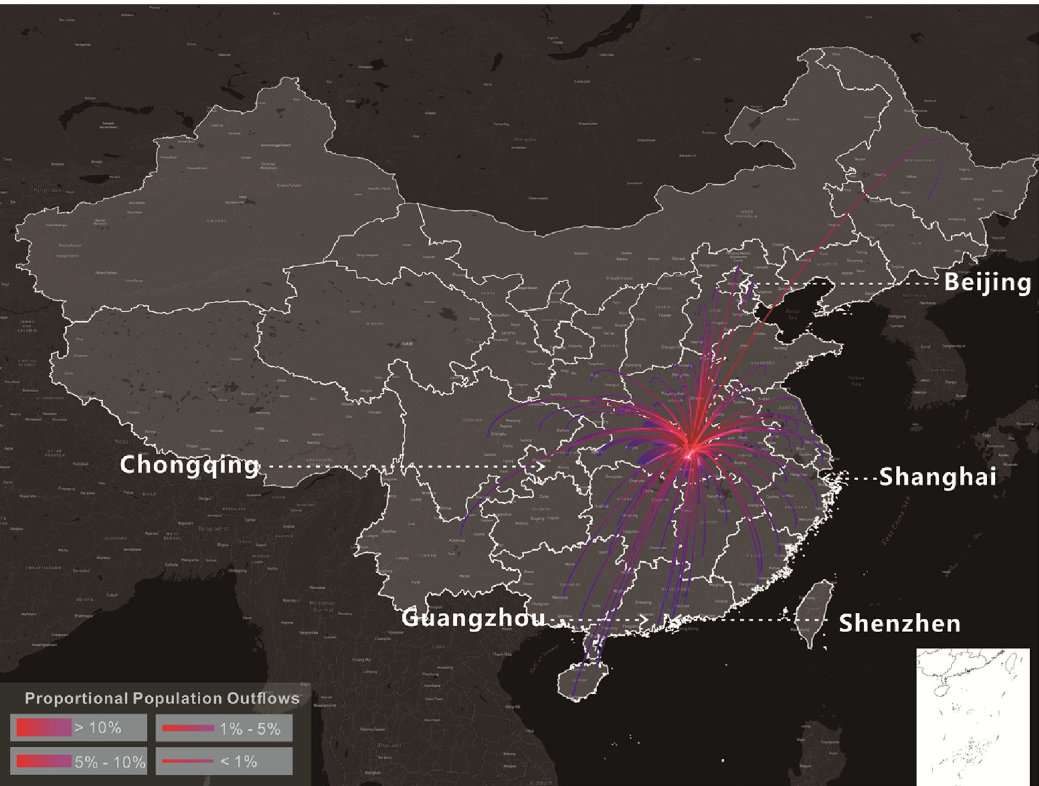
Fig. 4 The percentage out fl ows of migrants from Wuhan to 100 cities in China which received the largest numbers of Wuhan migrants, on 8 December 2019 – 23 January 2020. The lowest percentage of Wuhan migrants received by any of the 100 cities was 0.02%. This fi gure is based on the massive positioning service data on the Baidu Map platform, available on https://qianxi.baidu.com/ 38 . Several hotspot destinations of the Wuhan migrants are labelled in this fi gure. Lines with gradient colours represent the distance from the origin (Wuhan, shown in red) to the 100